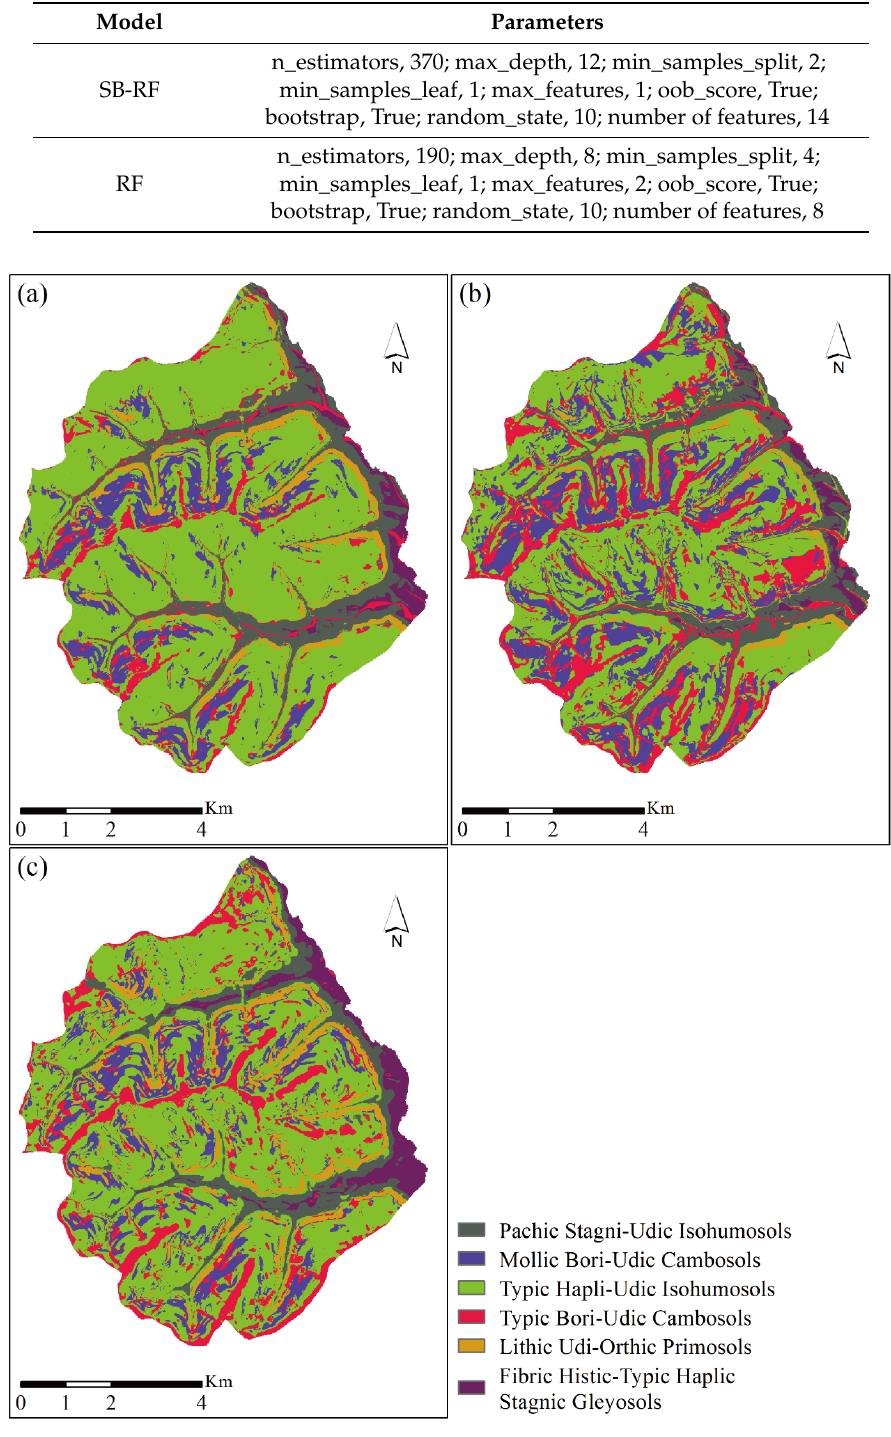
Figure 5. Soil maps generated from ( a ) Integration of similarity-based approach and random forests (SB-RF), ( b ) Similarity-based approach (SB), ( c ) Random forests method (RF).